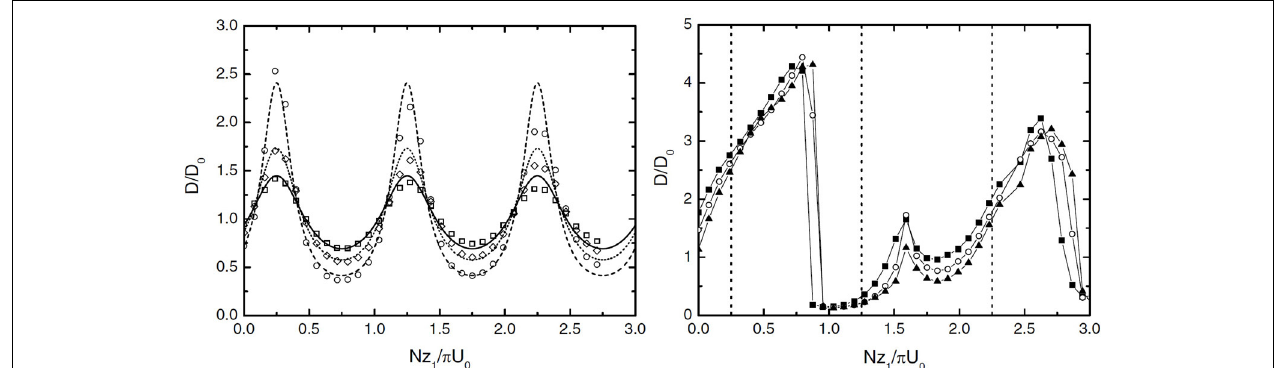
circles: Ri c = 0 . 5. Right: Numerical simulations for ˜ h = 0 . 5. Squares: Ri c = 2, circles: Ri c = 1, triangles: Ri c = 0 . 5. Reproduced from Figures 1, 5 of Teixeira et al. [96]. Copyright © 2005 Royal Meteorological